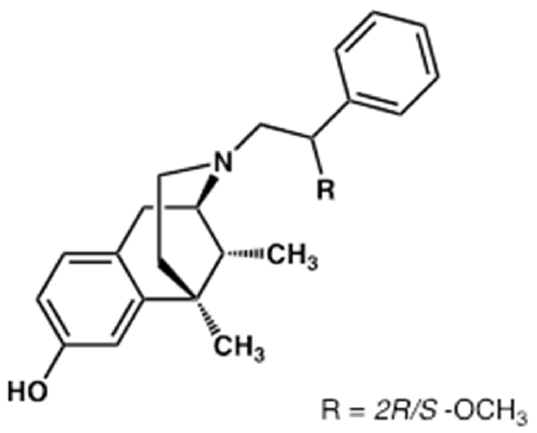
Figure 1. Chemical structure of (2 R / S ) ‐ N ‐ 2 ‐ methoxy ‐ 2 ‐ phenylethyl ‐ 6,7 ‐ benzomorphan (LP2).